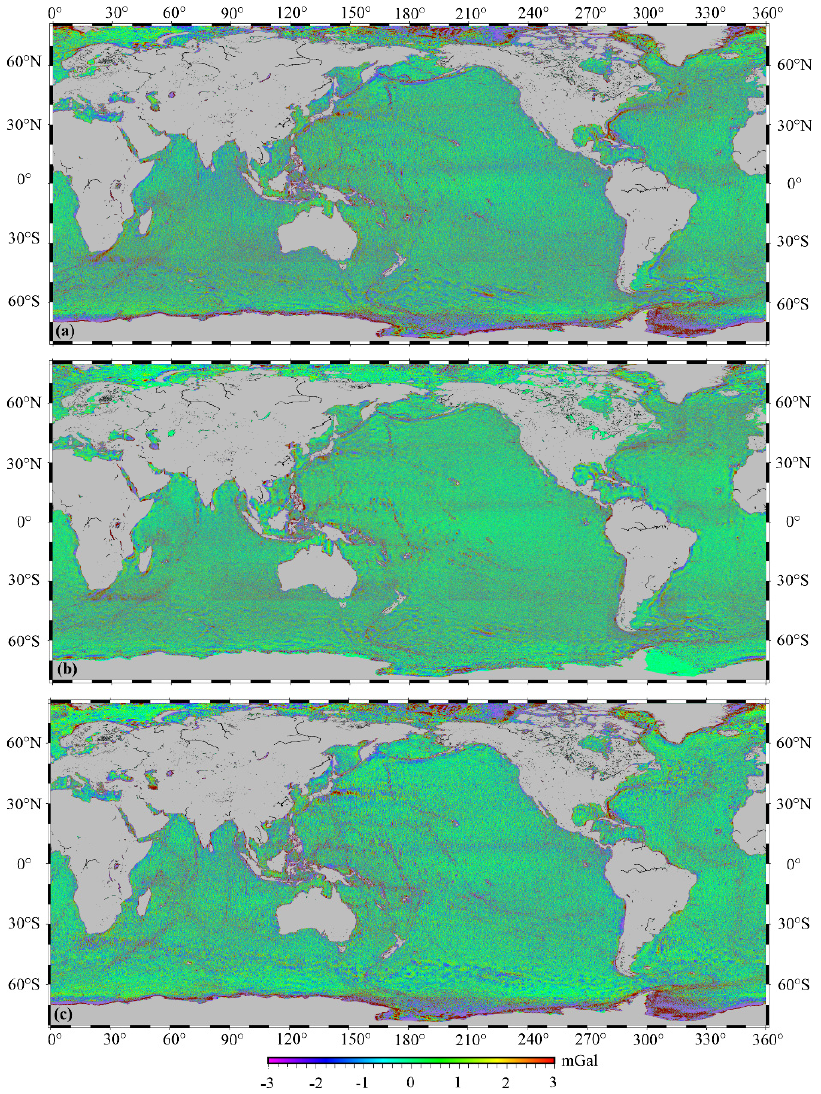
Figure 2. Marine gravity anomaly (free air) differences, ( a ) between SDUST2021GRA and SIO V31.1, ( b ) between SDUST2021GRA and DTU17, ( c ) between SIO V31.1 and DTU17.